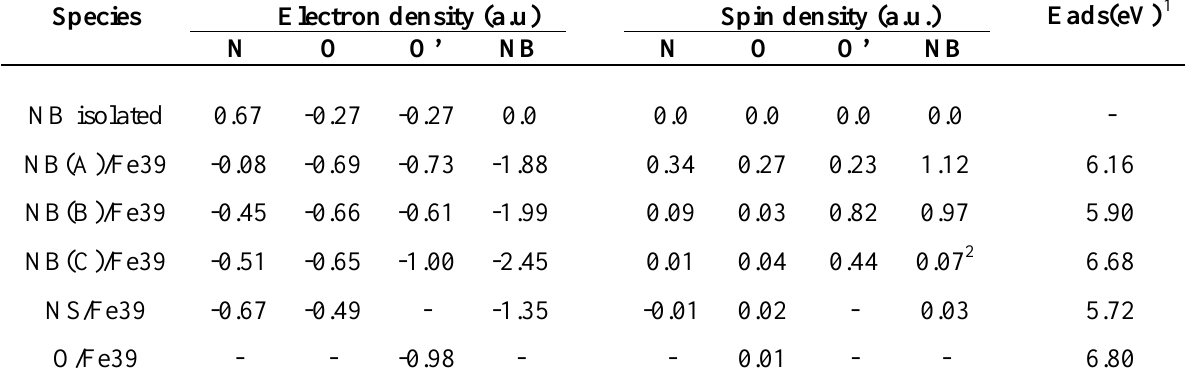
Table 3. Adsorption nergy and population analysis for nitro group of NB and NS adsorbed on